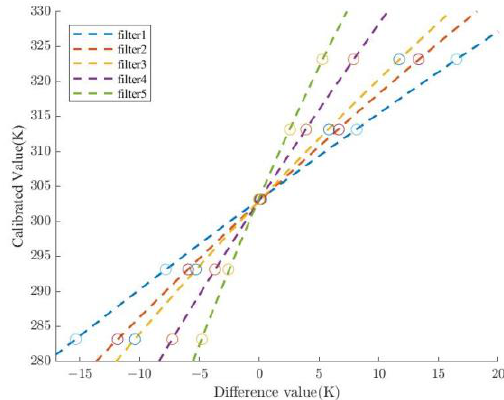
Figure 5. Calibration fitting of blackbody in temperature from 0 to 50 °C. The dashed line is the fitting curve, and the circle is the difference value between output and ambient temperature blackbody.